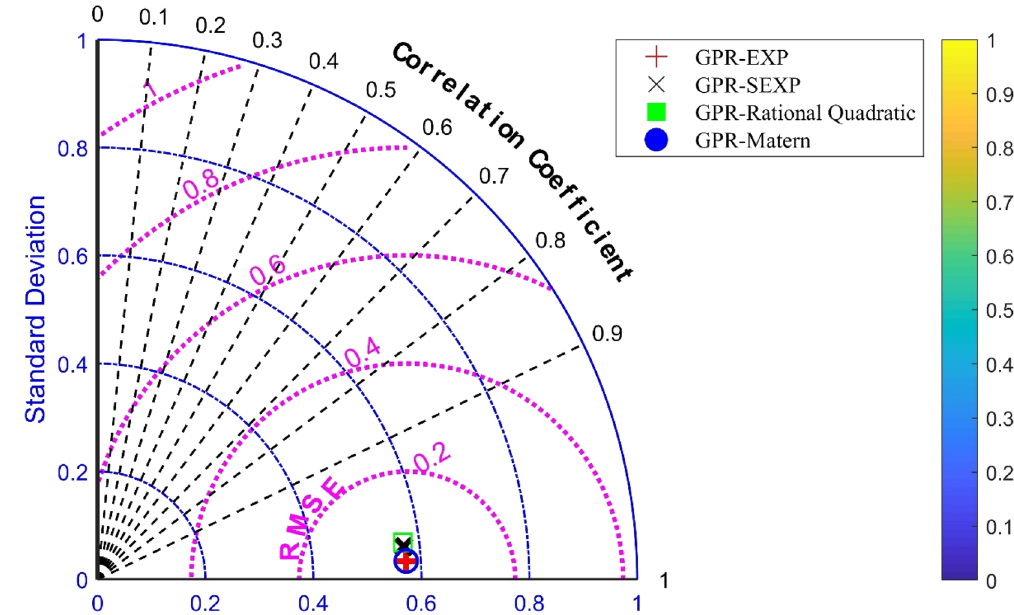
Figure 4. Taylor plot for GPR models.